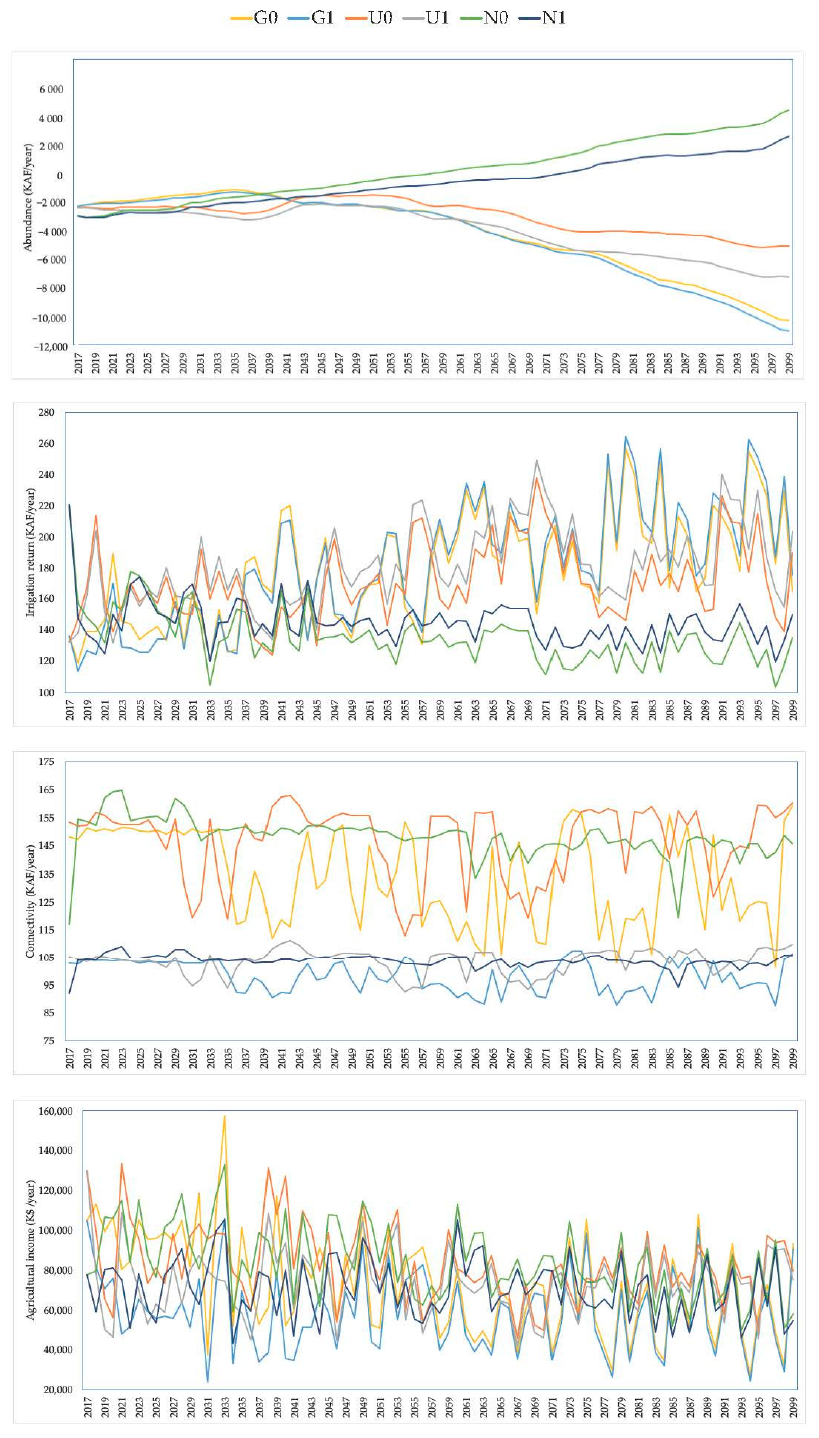
Figure A3. Simulation results for selected variables with three climate projections.